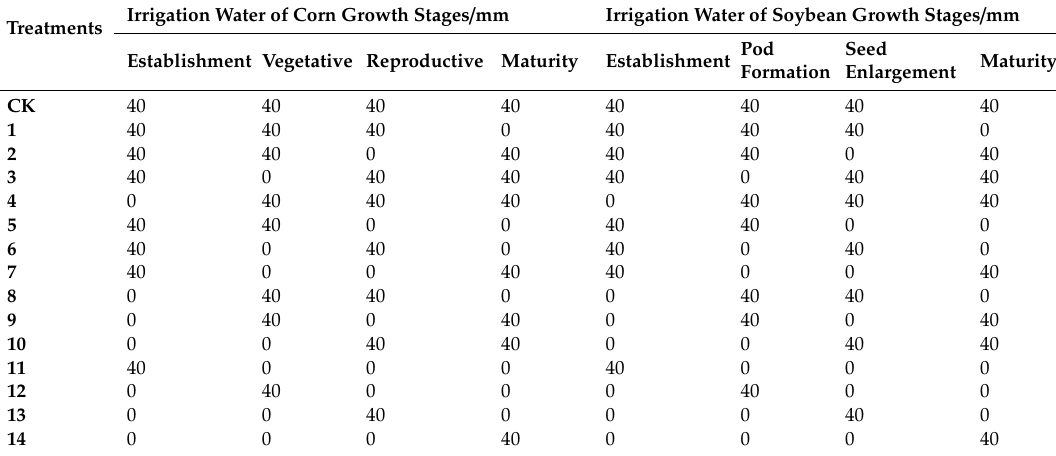
Table 2. Crop water production function irrigation treatments.